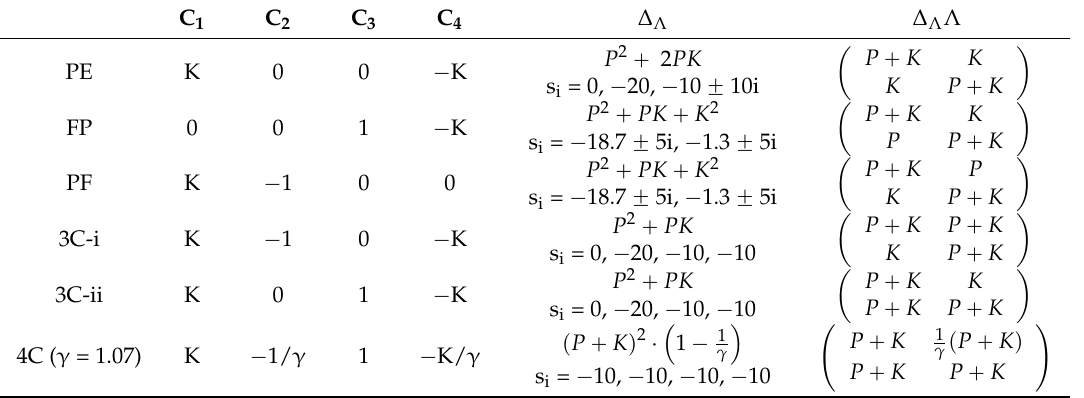
Table 1. Control Schemes (P m = P s = P = 0.001s 2 + 0.02s, C m = C s = K = 0.1, C 5 = C 6 = K’ = 0). C